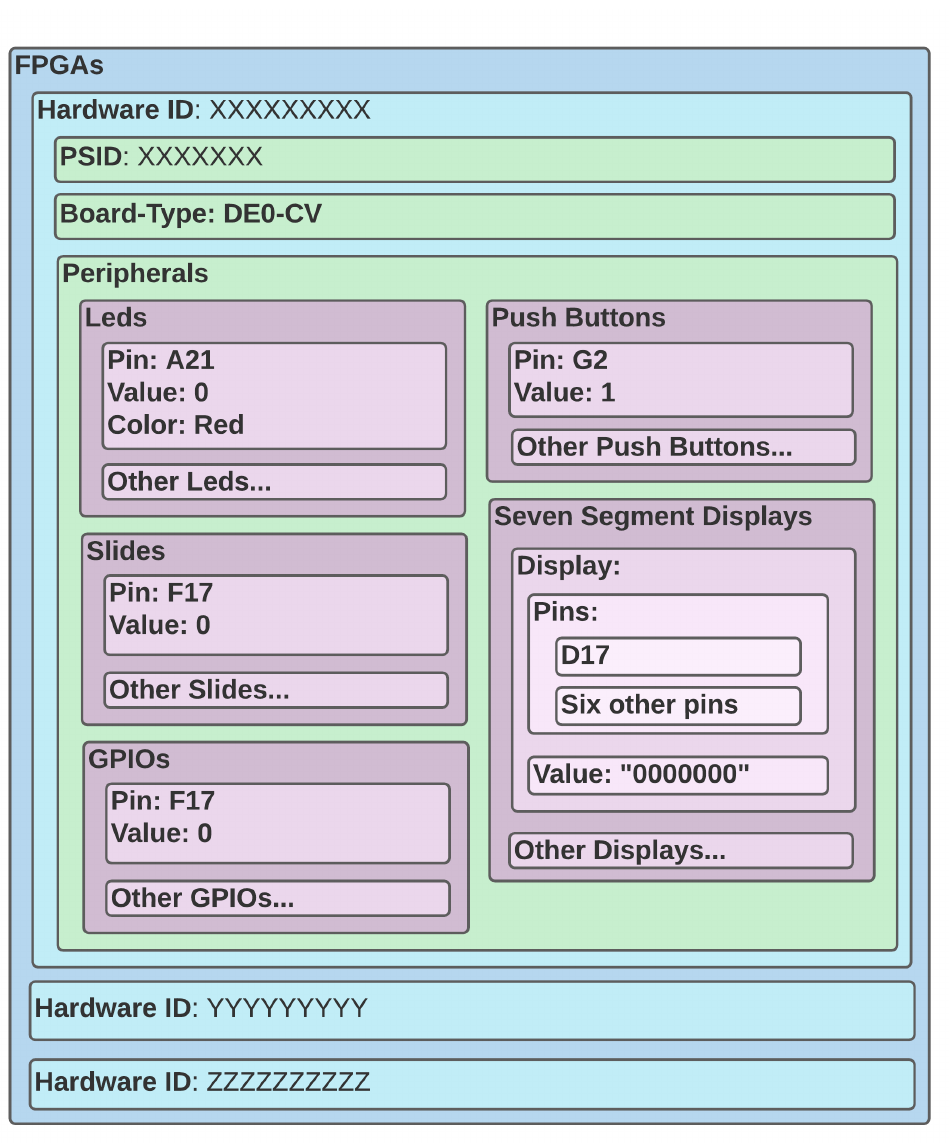
Figure 3. Google Firebase real-time database